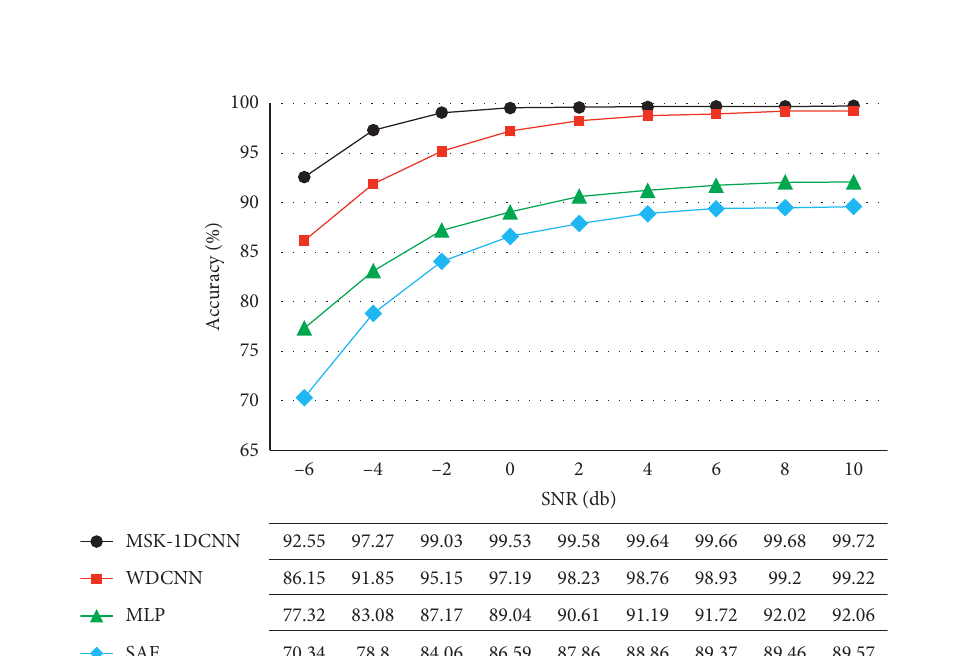
Figure 6: Comparison of diagnosis